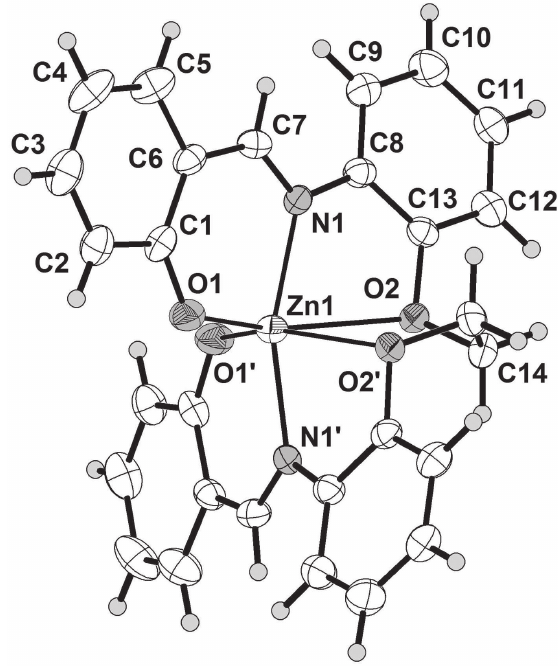
Table 1: Data collection and handling.